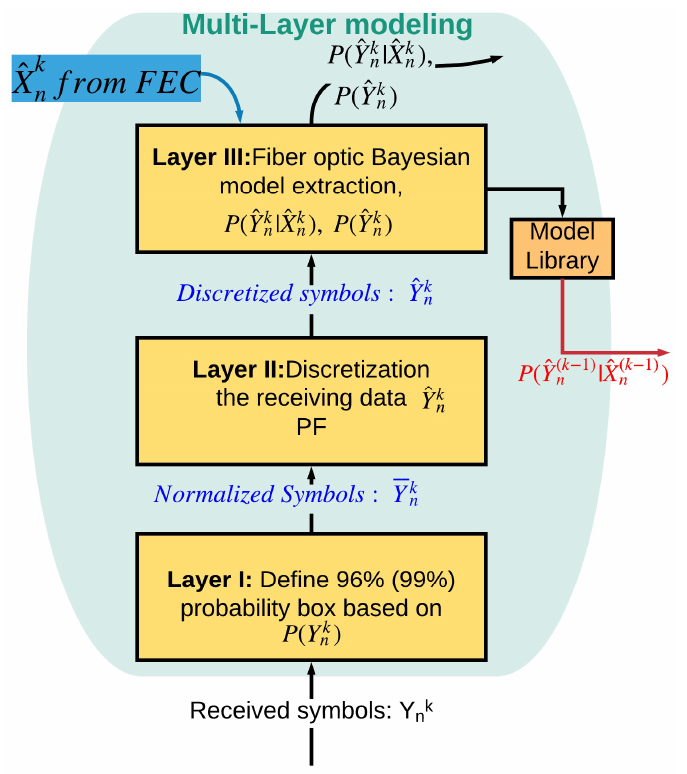
Figure 8. Three layered Bayesian modeling inspired by the brain for modeling fiber optic link.